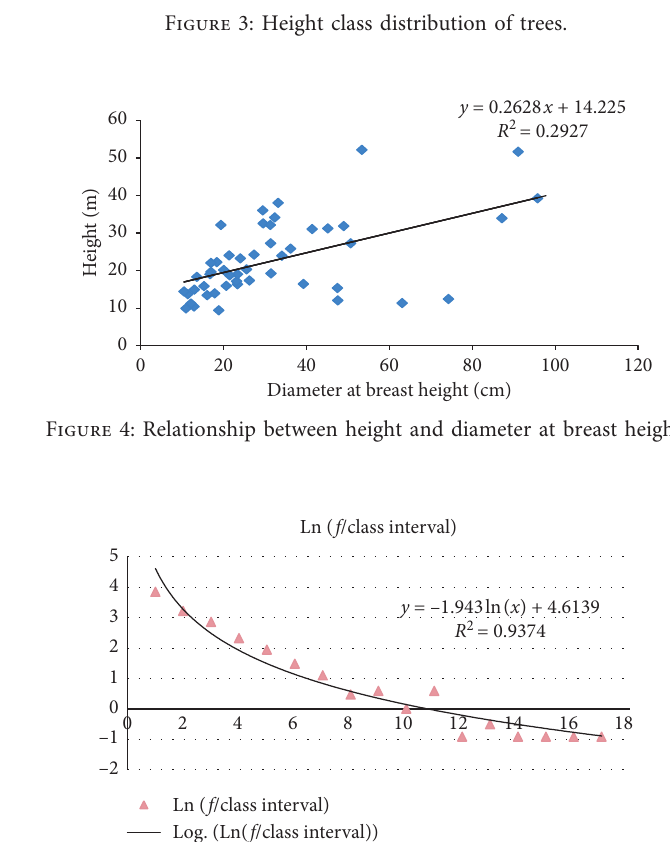
Figure 5: SCD curve showing regeneration status based on the log of frequency over a class interval. Ln � log; F � frequency.